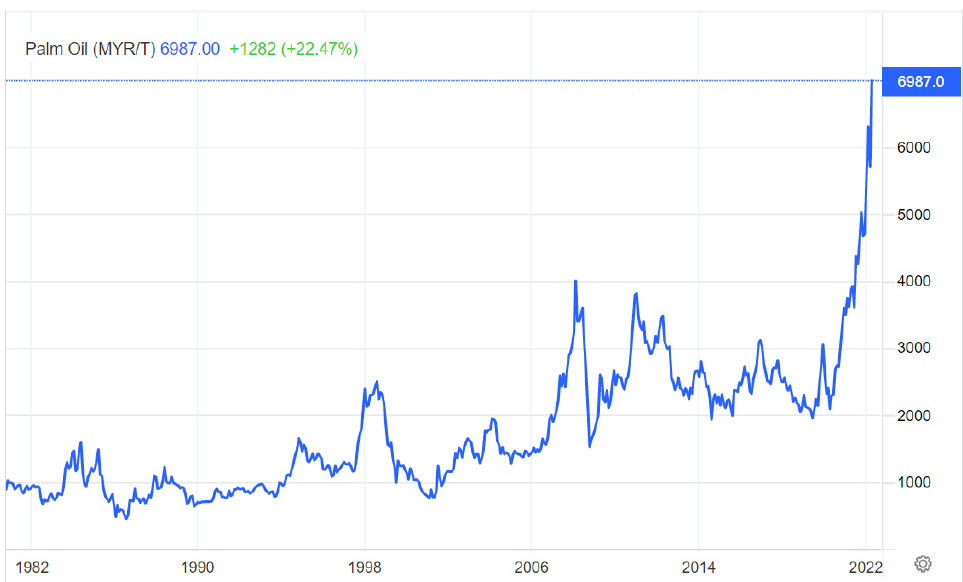
Figure 1. Palm oil price spot contract monthly average prices since 1980, traded at Bursa Malaysia. (Retrieved from tradingeconomics.com accessed on 28 April 2022).